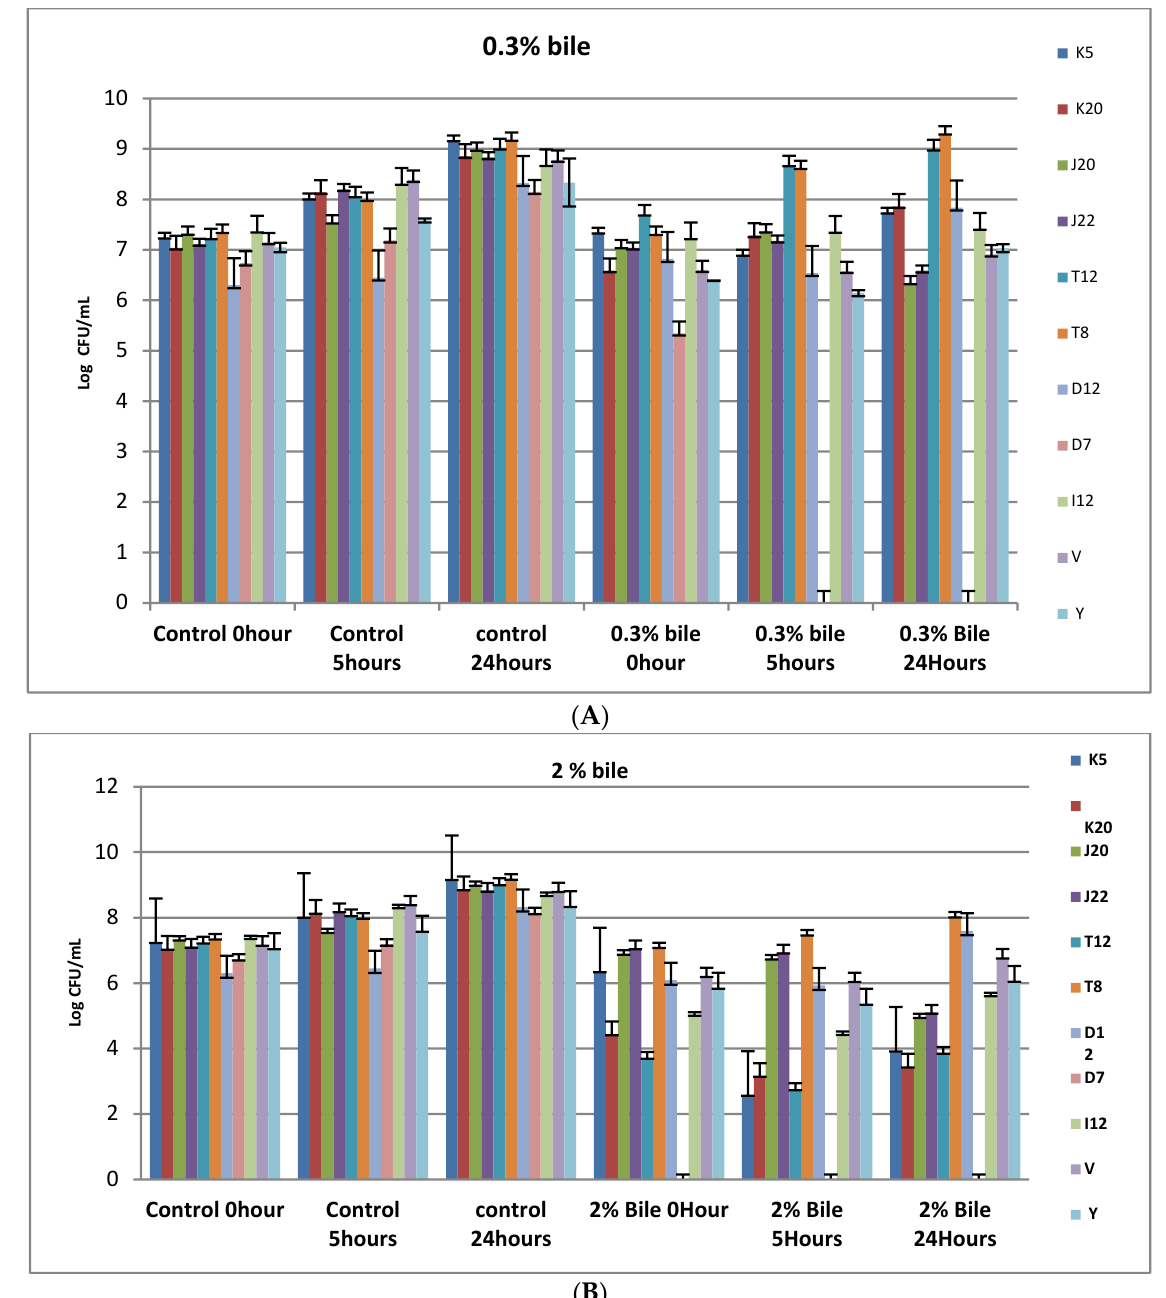
Figure 2. ( A ) Bile tolerance of LAB strains (K5, K20, J20, and J22, T12, T8, D12, D7, I12, V and Y) cultured in 0.3% bile and incubated at 37 °C for 24 h. Each bar represents the mean of duplicate determinations (n = 3); ( B ) Bile tolerance of LAB strains at 2% bile. Each bar represents the mean of duplicate determinations (n = 3). Isolate codes (K5, K20, J20, J22, T12, T8, D12, D7 and I12) represented by single letter and number indicate the strain number where the strains were